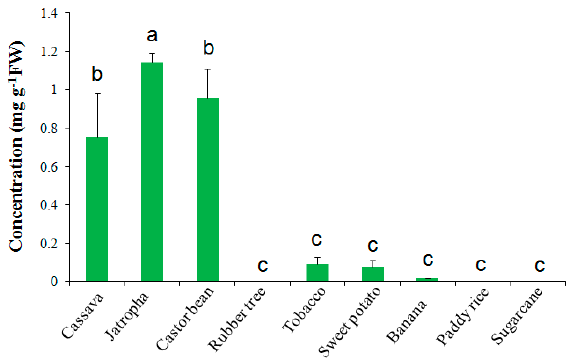
Figure 2. Trehalose concentrations in leaves of different plant species under normal conditions. The contents were measured with HPLC-ELSD method, and presented in mg ¨ g ´ 1 FW (Fresh Weight). The